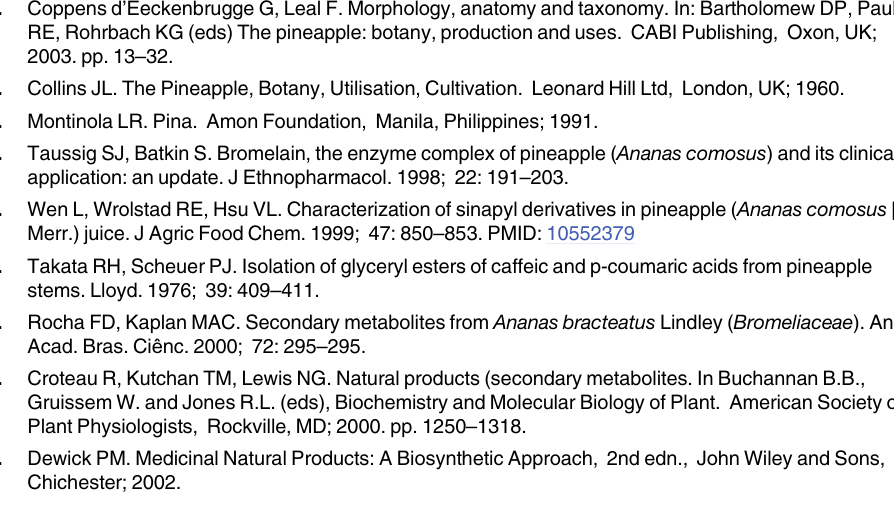
S1 Table. Sequences with significant BLASTn matches against Nr, Swiss-Prot database and other databases. S2 Table. KEGG biochemical mappings for A . comosus var. bracteatus . S3 Table. Distribution of conversation between A . comosus var. bracteatus unigenes and pineapple EST sequences based on tBLASTX scores. S4 Table. Unigenes of A . comosus var. bracteatus with hits to rice, maize, sorghum and Ara- bidopsis based on BLASTx method. S5 Table. Unigenes of A . comosus var. bracteatus encoding key enzymes in the terpenoid and phenylpropanoid biosynthesis